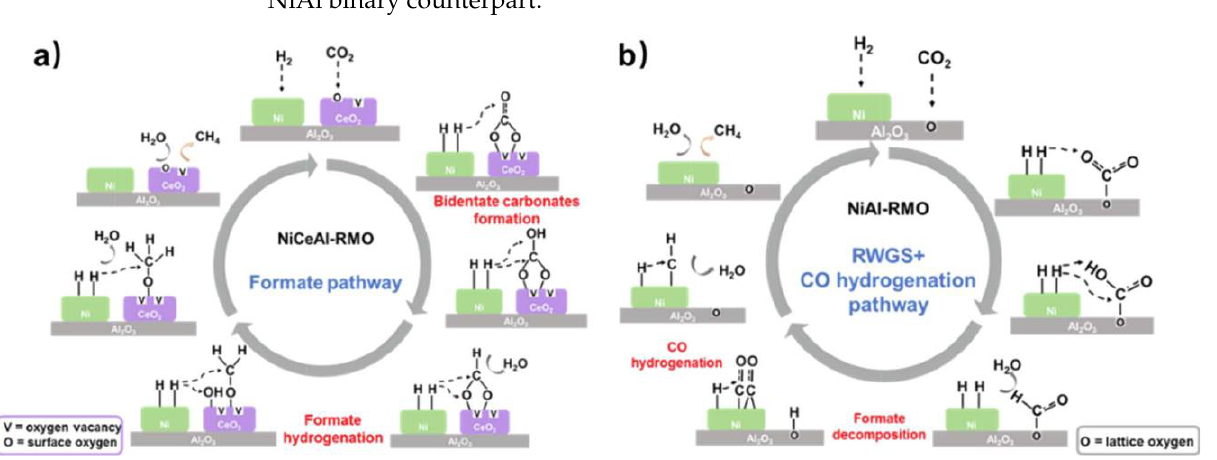
Figure 6. The role of oxygen vacancies in CO 2 methanation via ( a ) formate pathway and ( b ) CO pathway [250]. (Copyright 2022, Elsevier).